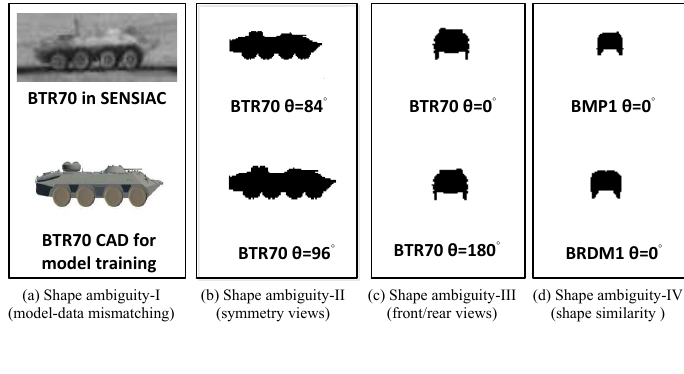
Figure 6. Possible reasons for the failure of the gradient descent